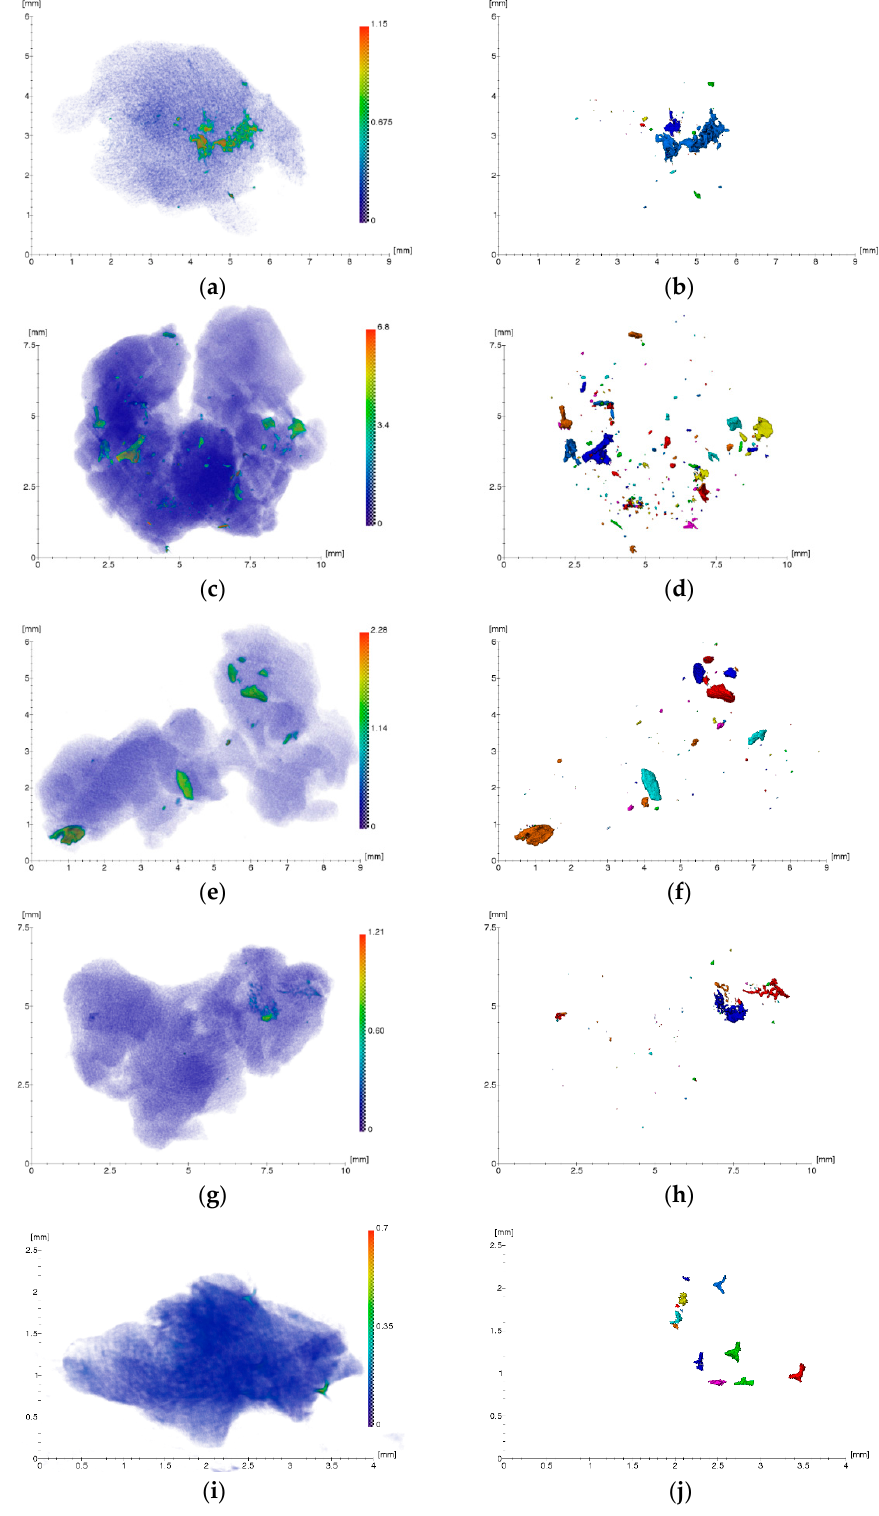
Figure 1. Results of three-dimensional reconstruction of biopsy specimens: ( a , c , e , g ) Original images of tissues with foreign inclusions; ( b , d , f , h ) resulting projections of foreign inclusions after segmentation procedure; ( i , j ) control specimen.